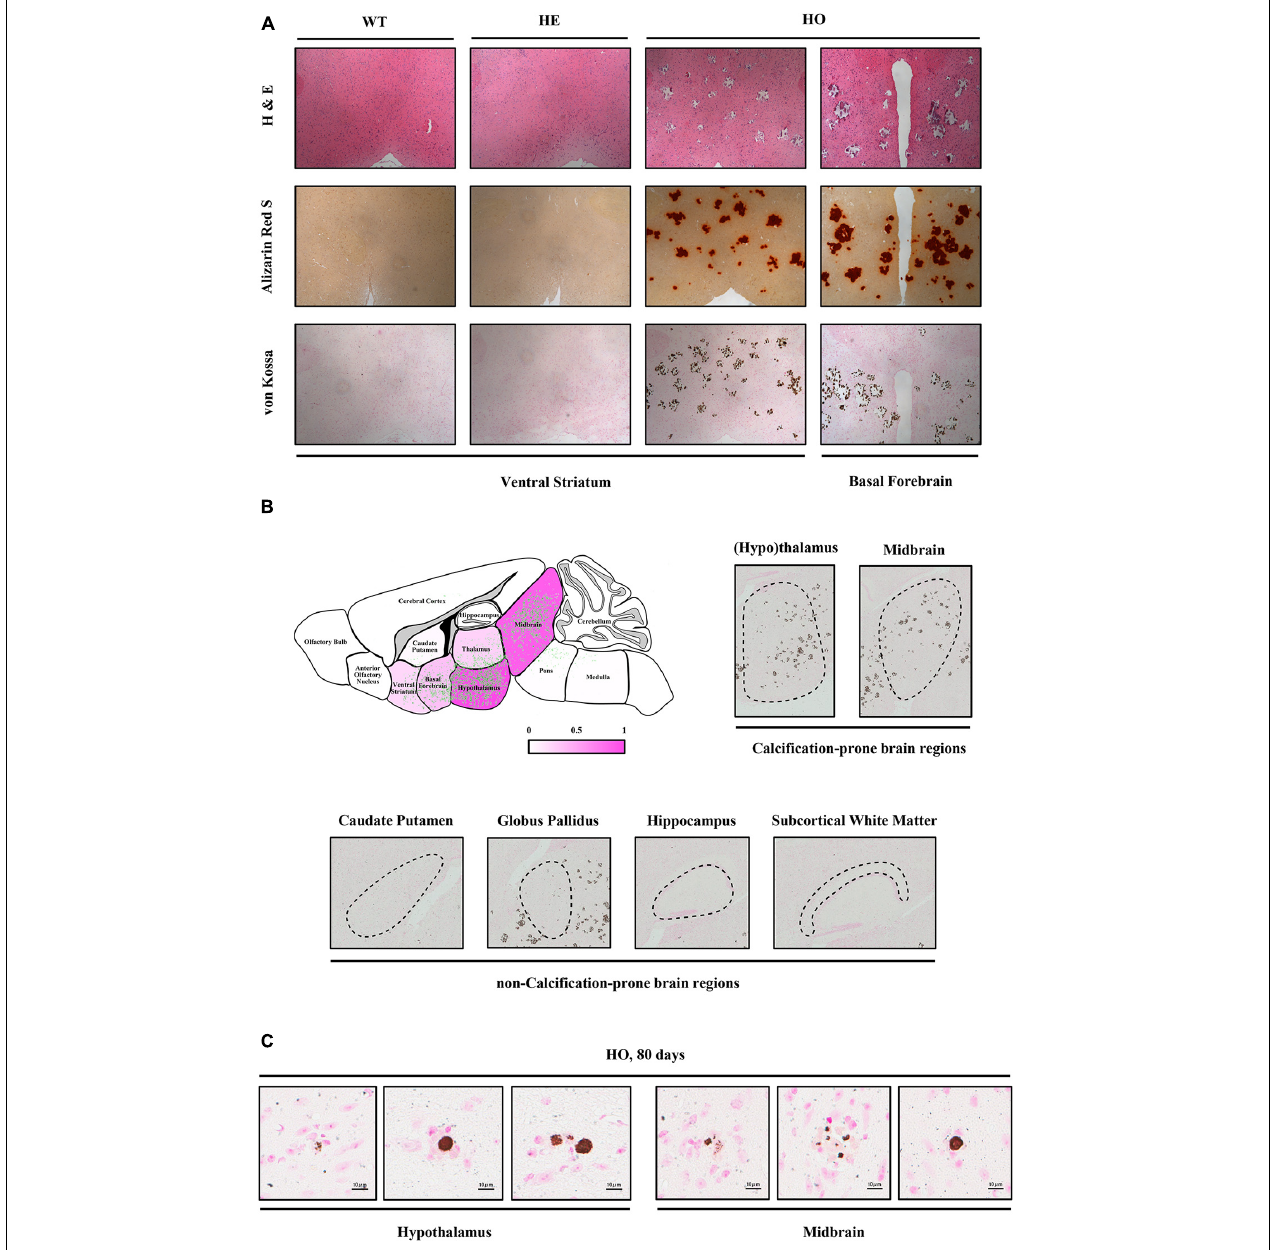
FIGURE 2 | Histopathological characteristics of Slc20a2 -deficient mice. (A) Calcium and phosphate staining on the coronal sections of different brain areas in genotype-defined mice. (B) Schematic diagram of calcification severity in different brain regions. Fuchsia and white represent calcification-prone and non-calcification-prone regions, respectively. Green dots indicate the distribution of brain calcifications from overlapping the actual calcified signals in 12 Slc20a2 -HO brains. Representative pictures of VK staining on the calcification-prone and non-calcification-prone regions of the severely calcified brain of a 10 month-old mouse. Black dash circles indicate the target brain region. (C) Scattered intracellular calcified granules in calcification-prone brain regions of 80 day-old mice. Pink staining indicates cell nucleus and brown spots represent phosphate depositions.